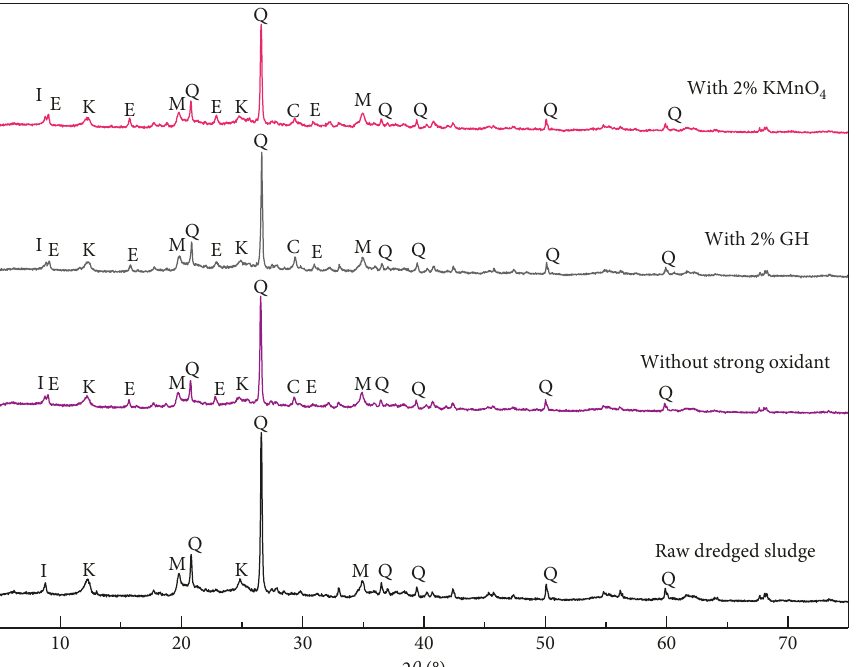
Figure 6: XRD patterns of raw dredged sludge and solidified samples. Q: quartz; K: kaolinite; E: ettringite; I: illite; M: muscovite; C: CaCo